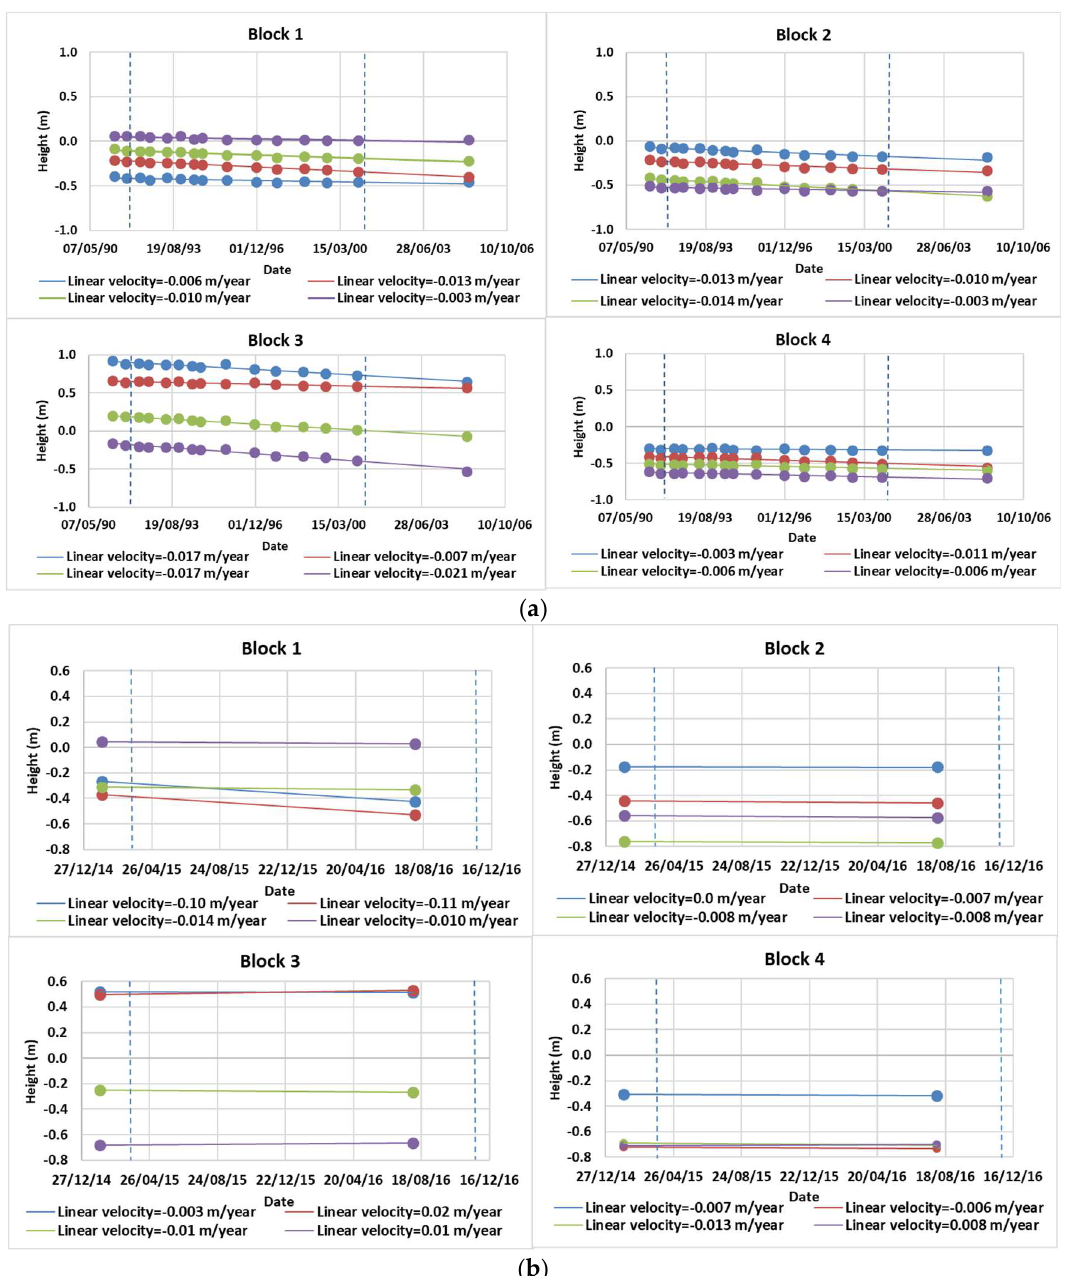
Figure 10. ( a ) the four levelling transect mean heights (m) in each block. The vertical dashed lines represent the start and end of ERS acquisitions; ( b ) the four levelling transect mean heights (m) in each block. The vertical dashed lines represent the start and end of Sentinel-1 SAR acquisitions.